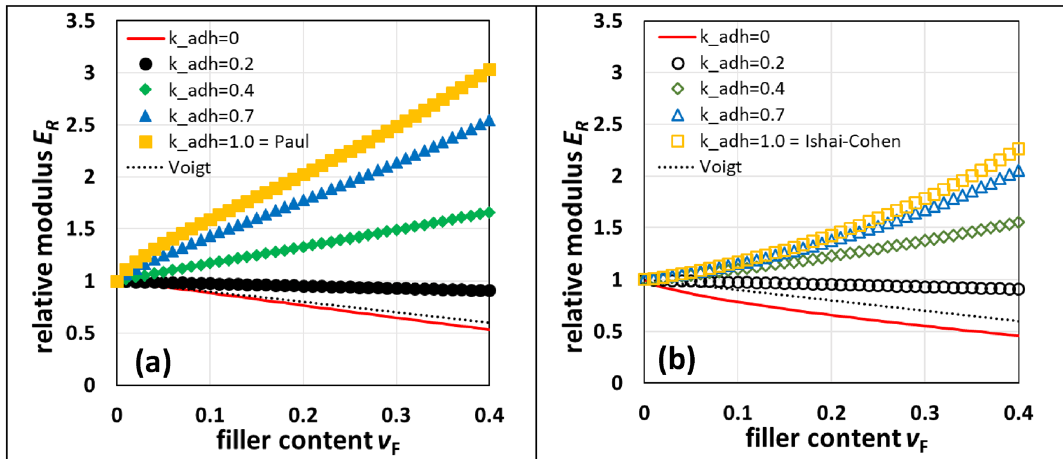
Figure 2. Calculated filler volume content dependent relative moduli E R for different adhesion factors k adh with E M = 3200 MPa and E F = 63,000 MPa for ( a ) in series EV arrangement and ( b ) parallel EV arrangement. The dotted line represents the decreasing E R for a foam with E F = 0 MPa according to